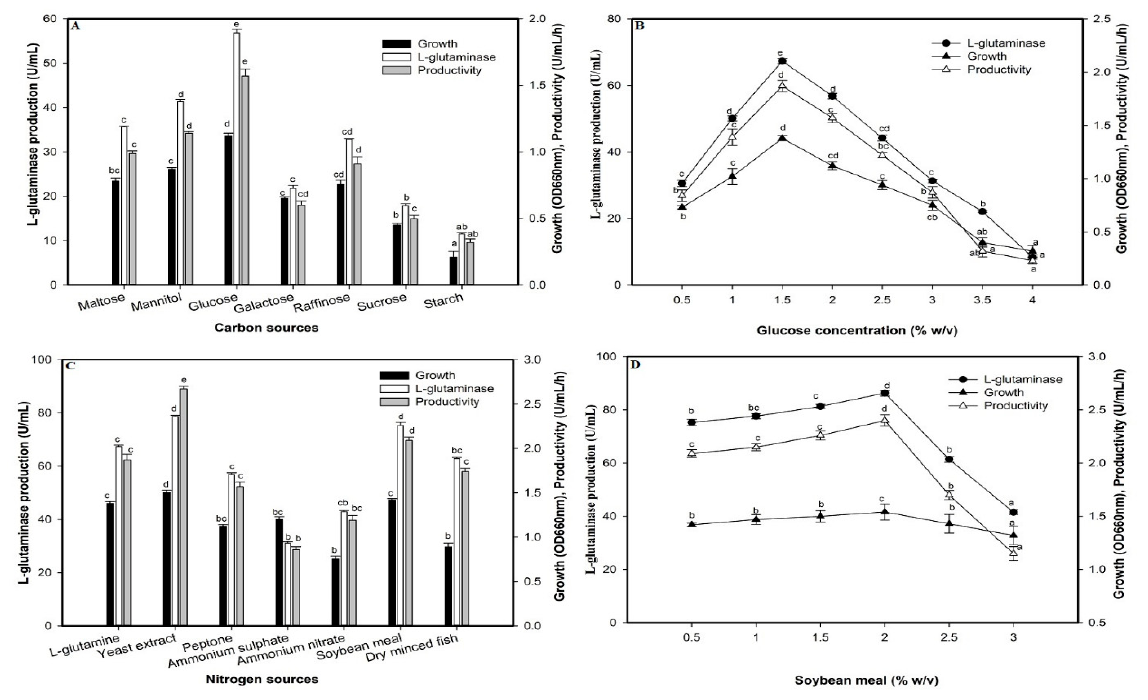
Figure 7. Effect of carbon sources ( A ), glucose concentration ( B ), nitrogen sources ( C ), soya bean meal concentration ( D ) on L-glutaminase production. Mean ± standard error ( n = 3) is presented. Vertical bars indicate the standard errors of the means. Means followed by different letters are significantly different at p < 0.05.